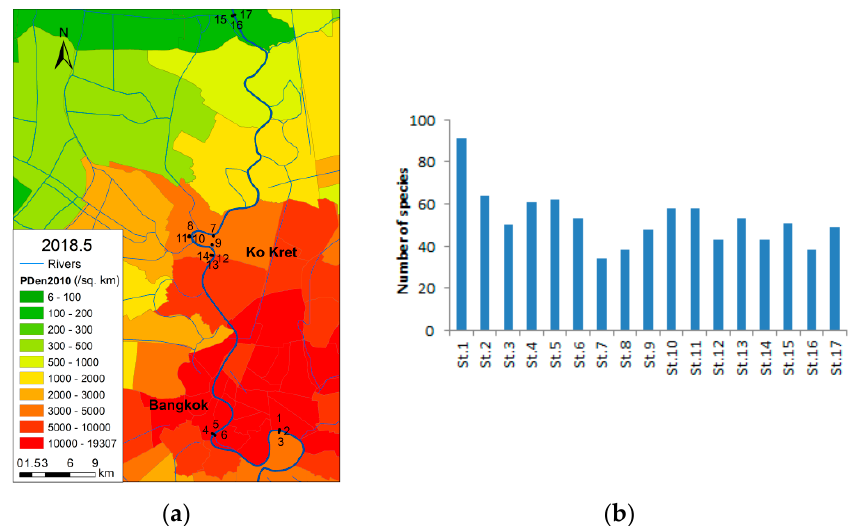
Figure 12. Sampling locations ( a ) and the number of identified species at each site ( b ).